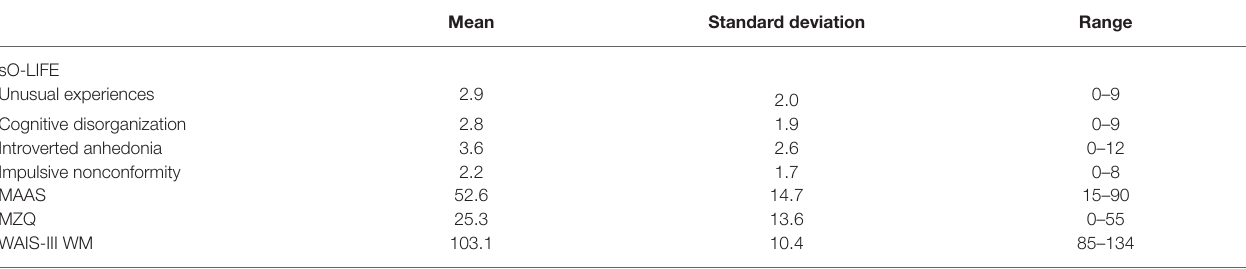
TABLE 1 | Descriptive data for schizotypal personality traits, mindfulness, mentalization, and working memory (WM).